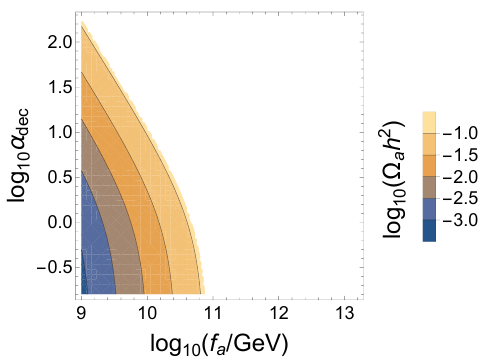
Figure 3. Relic density of QCD axion dark matter produced through misalignment and topological defects decay, in PQ unbroken scenario. The region shows axion relic density when it does not excess the overall cold dark matter (CDM) density Ω 2 = 0 . 12 . Reproduced from d h